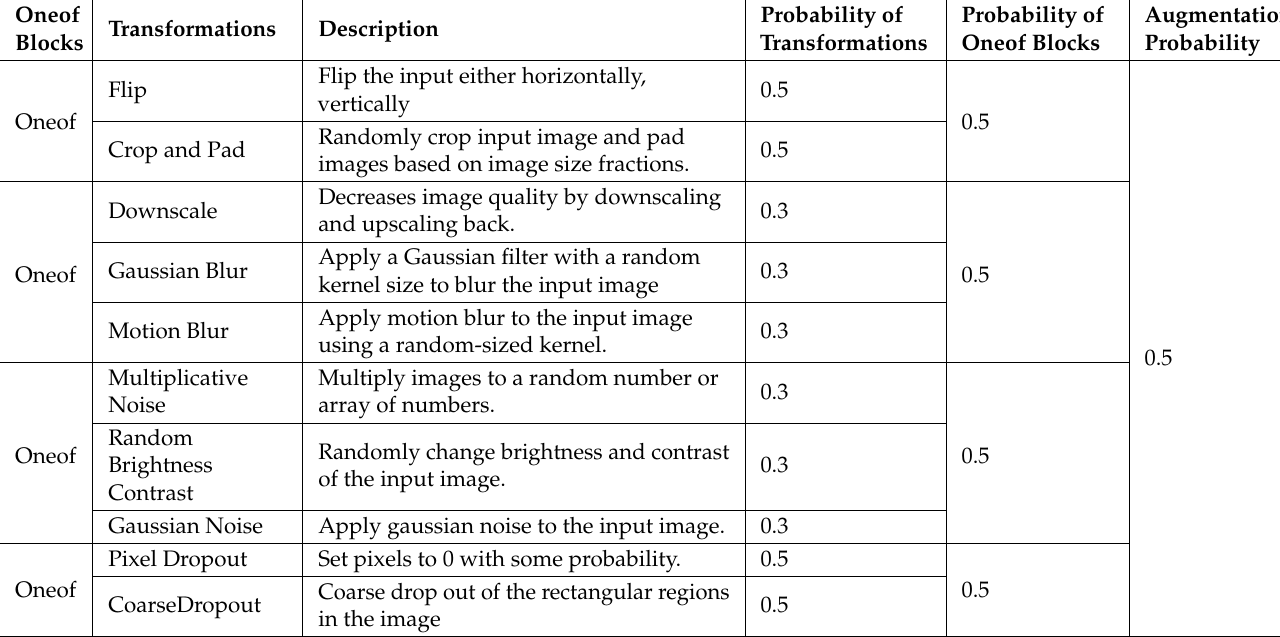
Table 2. The table presents the augmentation pipeline associated with transformation definitions along with their probabilities.